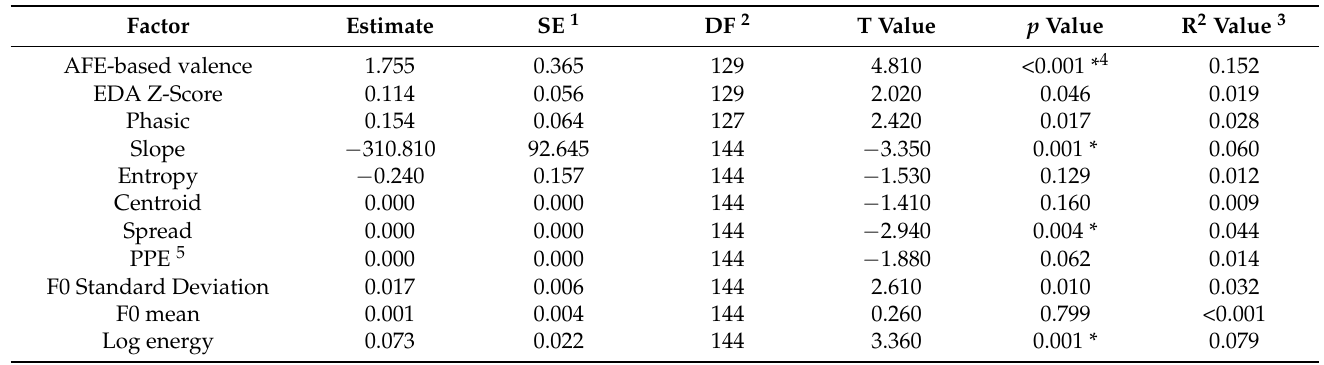
Table 6. Regression results of Arousal dimension.